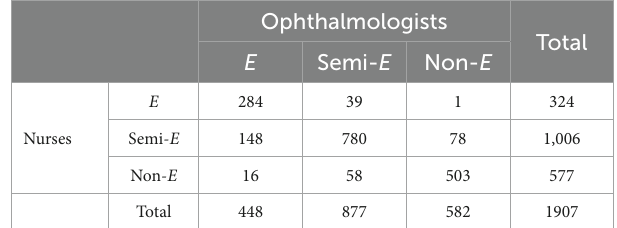
TABLE 3 Triage distribution of 1907 patients by nurses and by